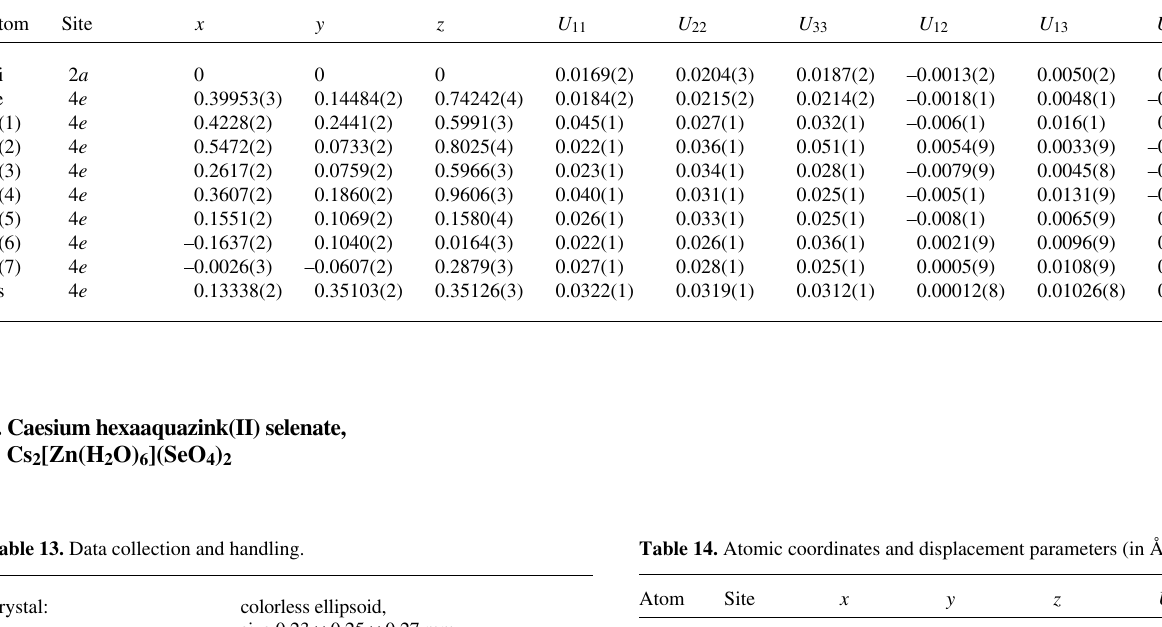
Table 12. Atomic coordinates and displacement parameters (in Å 2 )